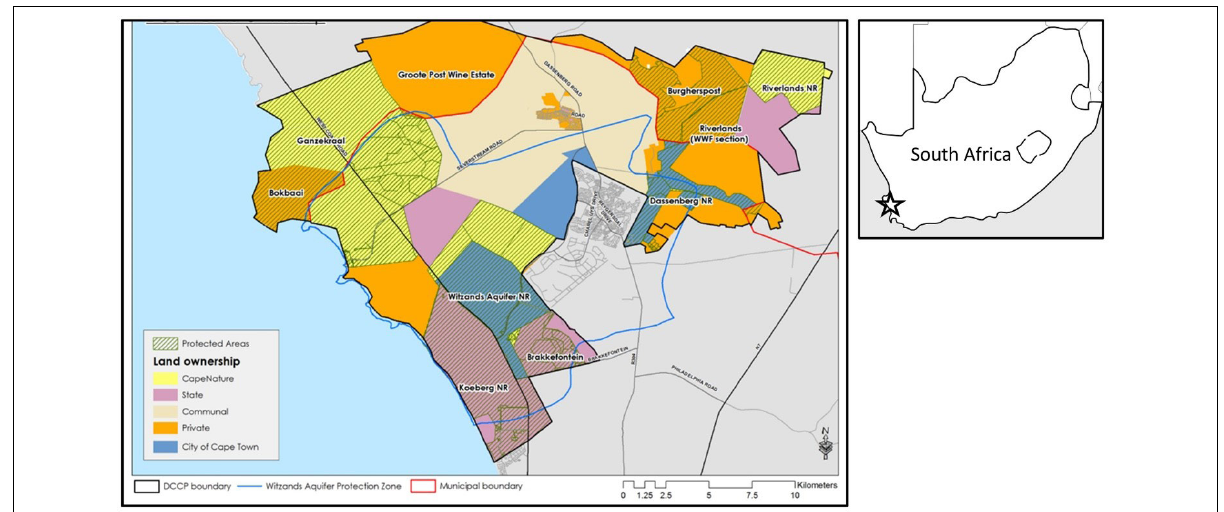
Figure 1: Map of the Dassenberg Coastal Catchment Partnership (DCCP) indicating landownership and represented in the context of South